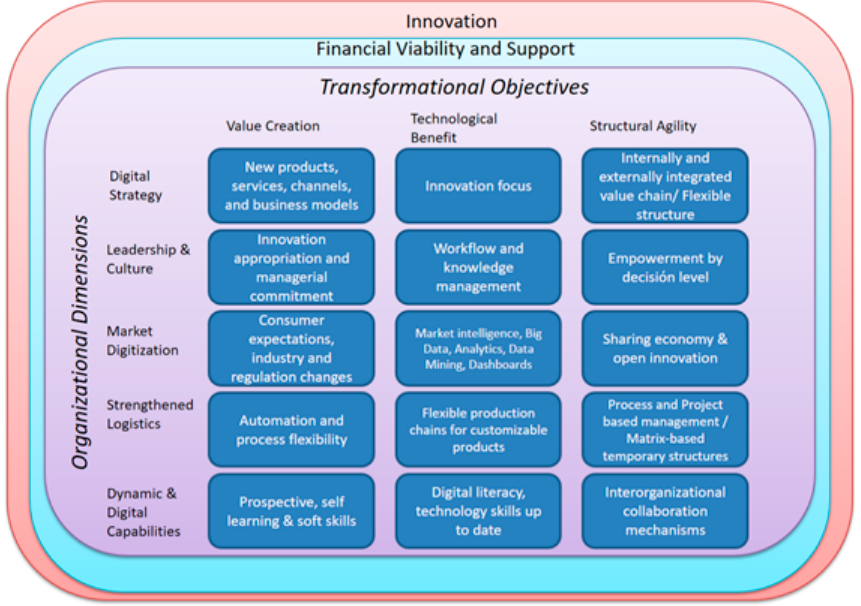
Figure 2. Multidimensional integrated model of digital transformation.